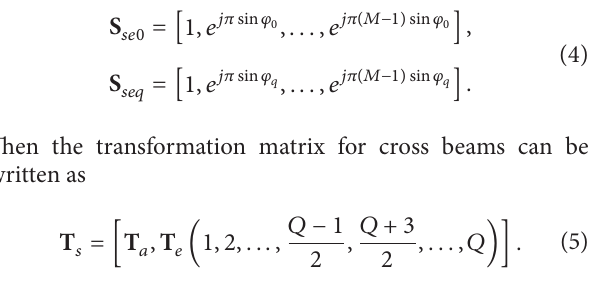
Figure 5: Adaptive weight normalized amplitude of the multibeams at the 28th Doppler